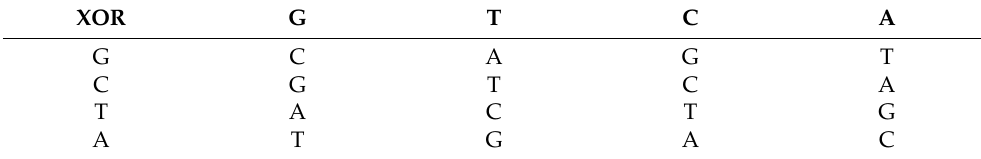
Table 2. XOR rules.